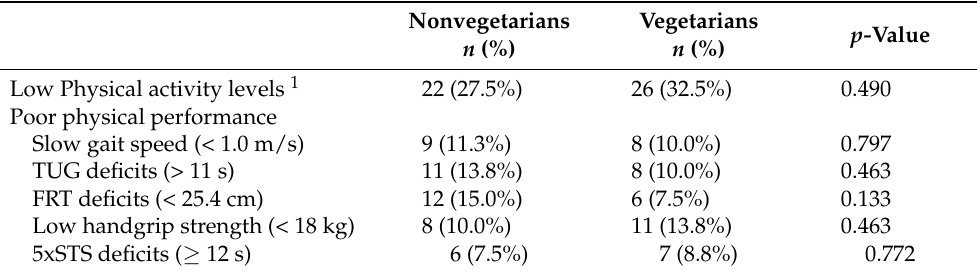
Table 3. Numbers of vegetarians ( n = 80) and nonvegetarians ( n = 80) with low physical activity levels and poor physical performance.